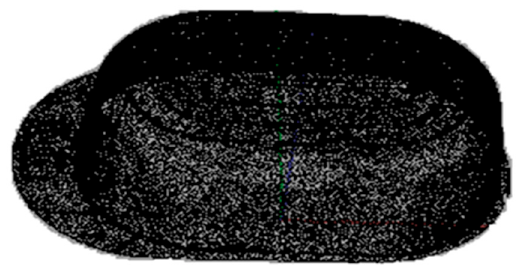
Figure 7. Point cloud data preprocessing modeling.